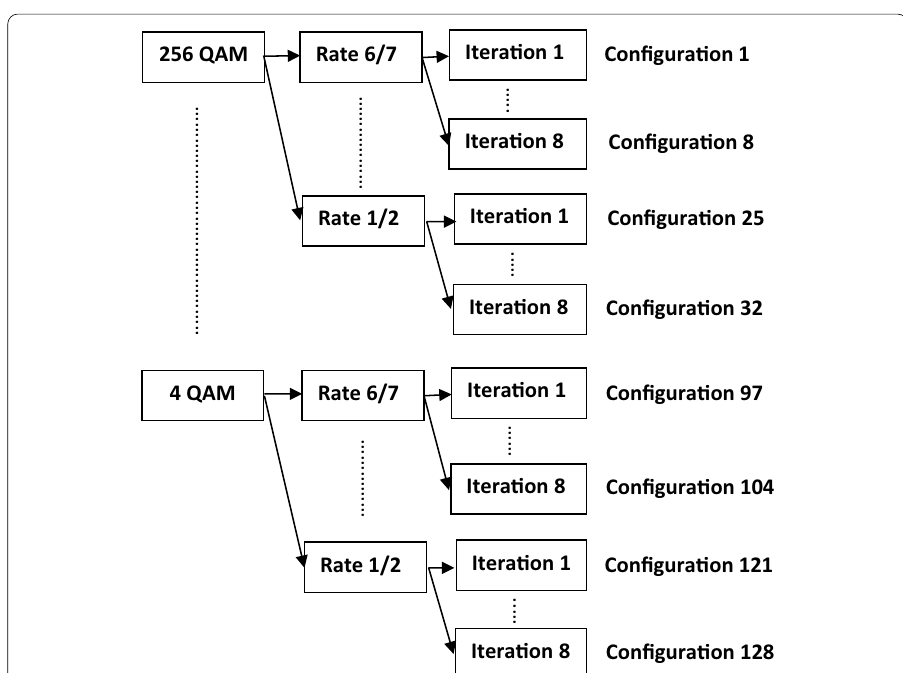
Fig. 7 The 128 BICM possible configurations. The BICM configurations that can be obtained according to the modulation order, turbo code rate and number of iterations for the turbo